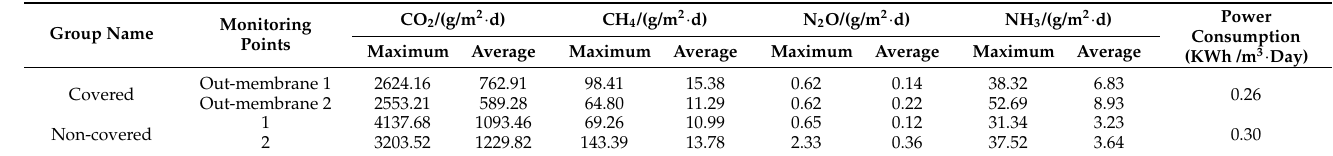
Table 2. Comparison of gas emissions and power consumption in two